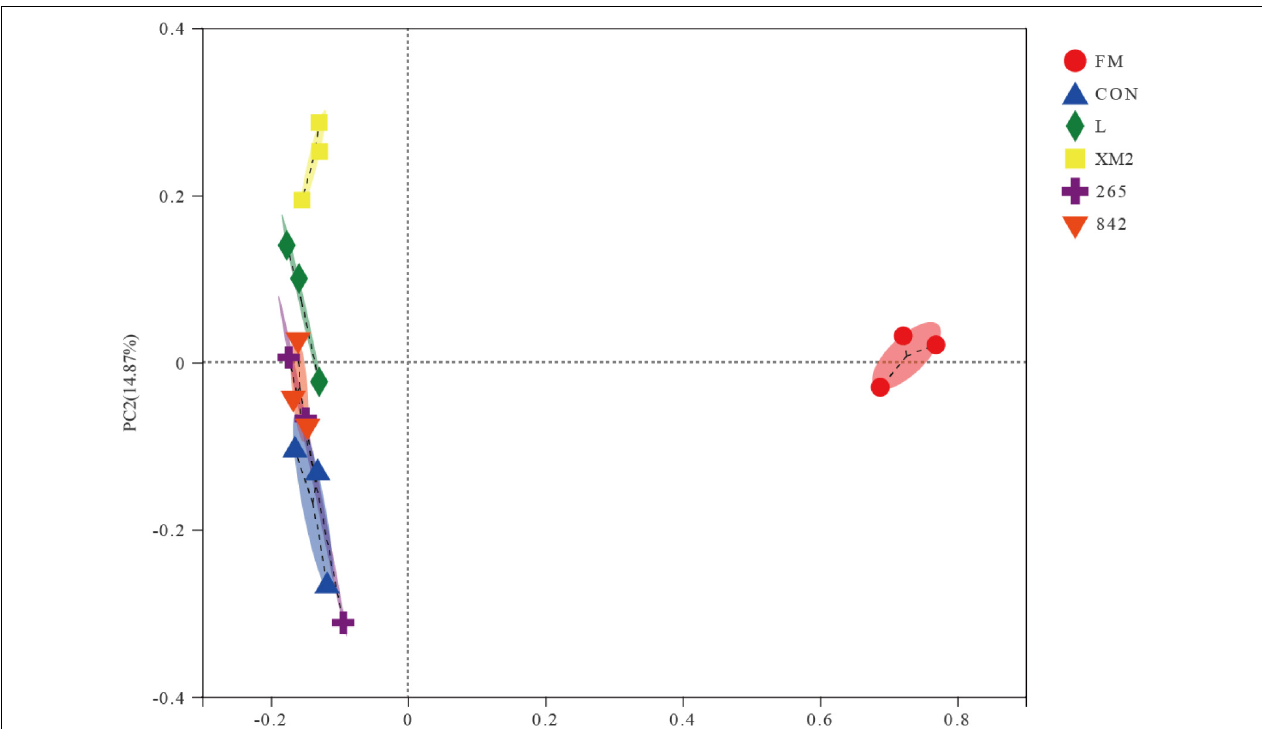
FIGURE 1 | Principal coordinate analysis (PCoA) of the bacterial community of FM and native grass on 30 days of ensiling. FM, fresh native grass; CON, control group; L, commercial inoculant group; XM2, strain XM2 group; 265, strain 265 group; 842, strain 842 group.